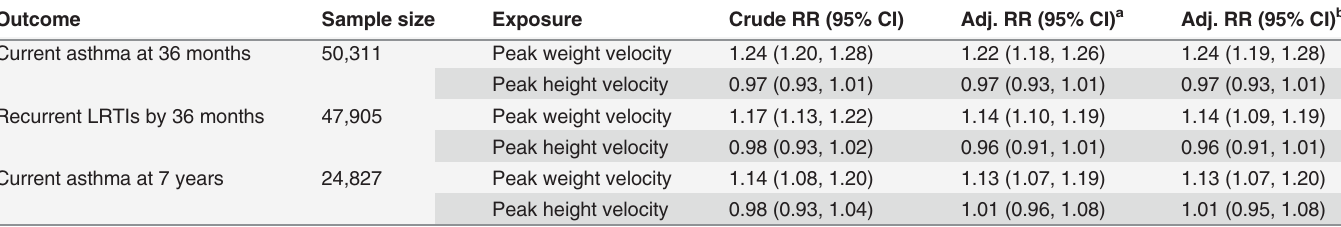
Table 2. Associations of one standard deviation increase in peak weight and height velocity the fi rst 36 months of life with development of respiratory